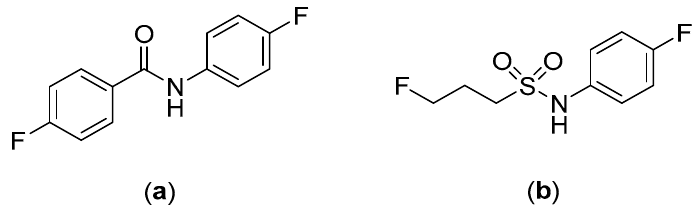
Figure 26. Structures of ( a ) N -(4-fluorophenyl)-fluoroacetanilide and ( b ) N -(4-fluorophenyl)-3- fluoropropane-1-sulfonamide [36].